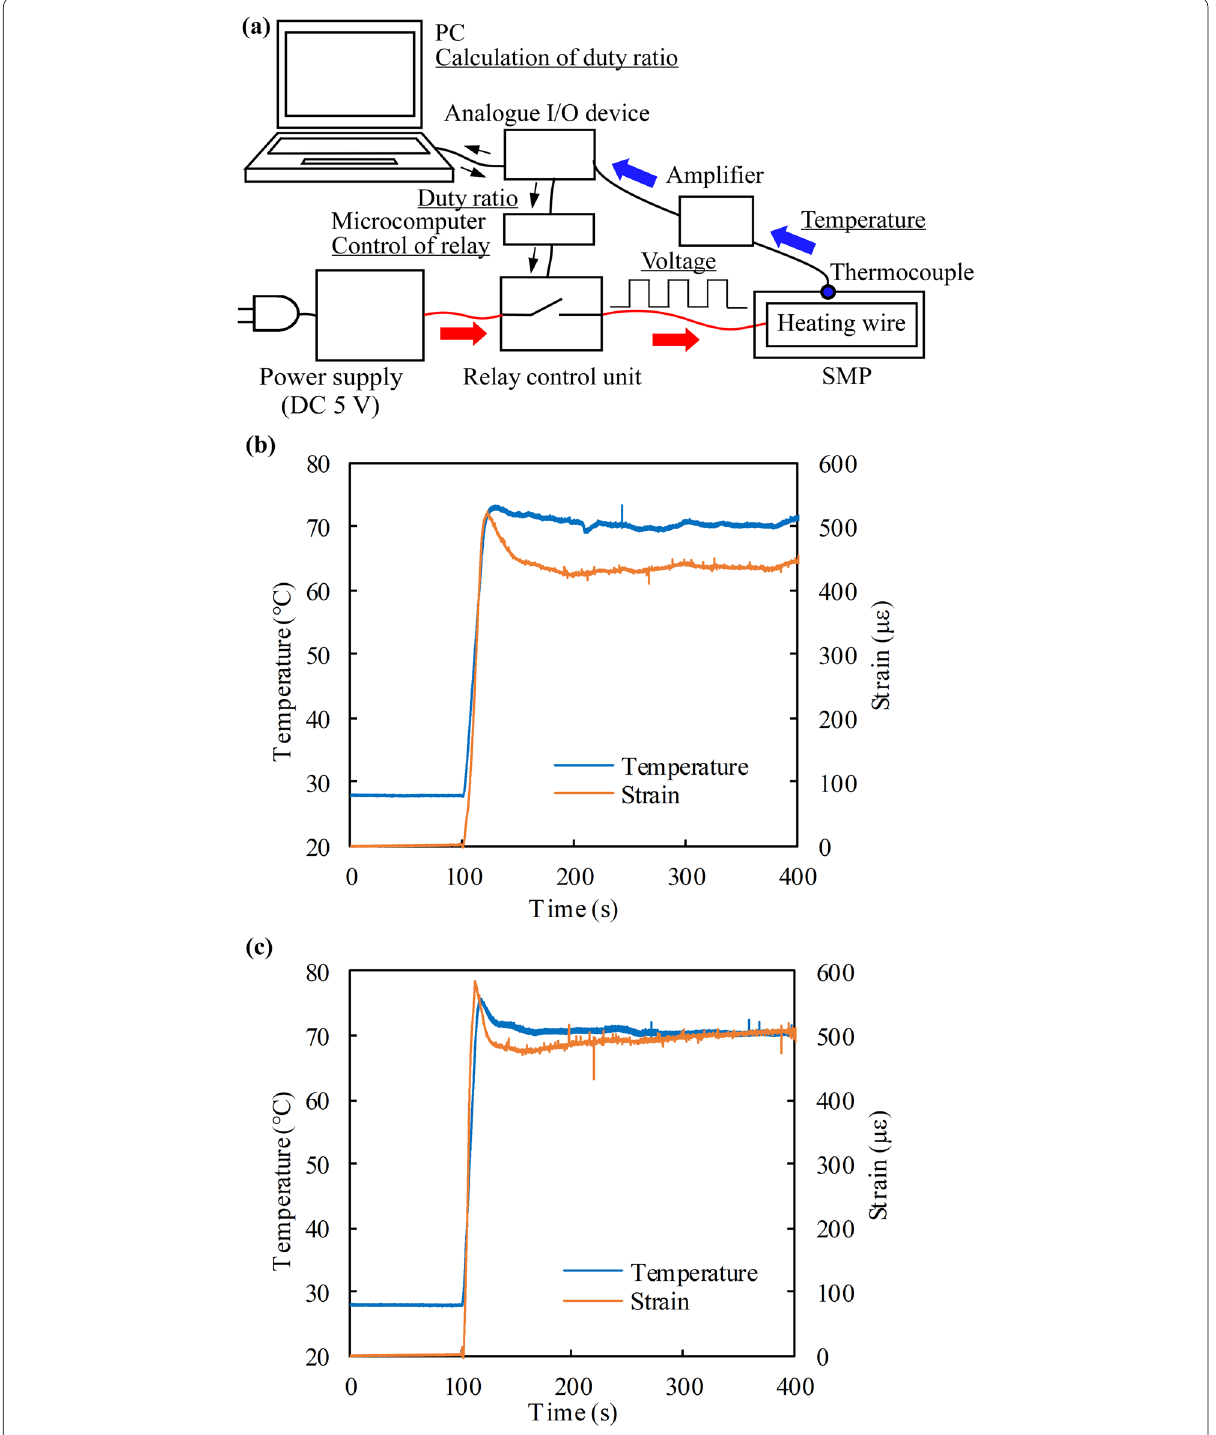
Fig. 4 a Schematic diagram of temperature control system. Change in surface temperature of SMP force sensor ( b #i and c